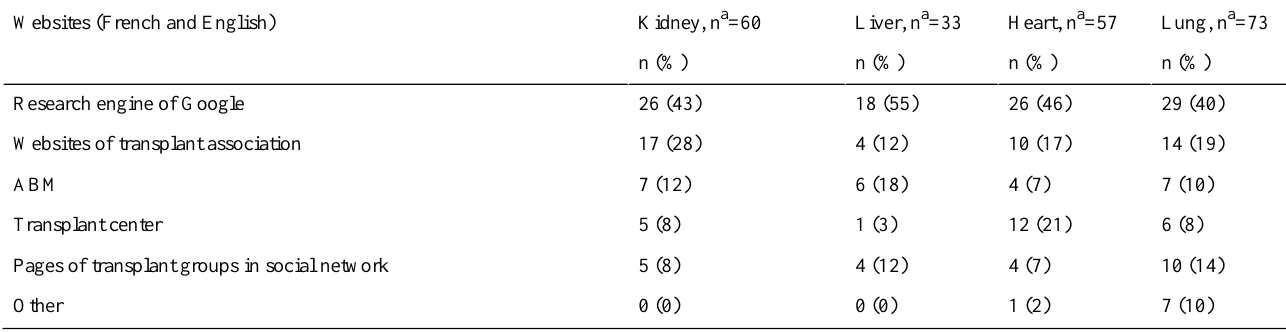
Table 3. Distribution of information sources provided by websites (French or English) for patients of each type of transplantation ( P